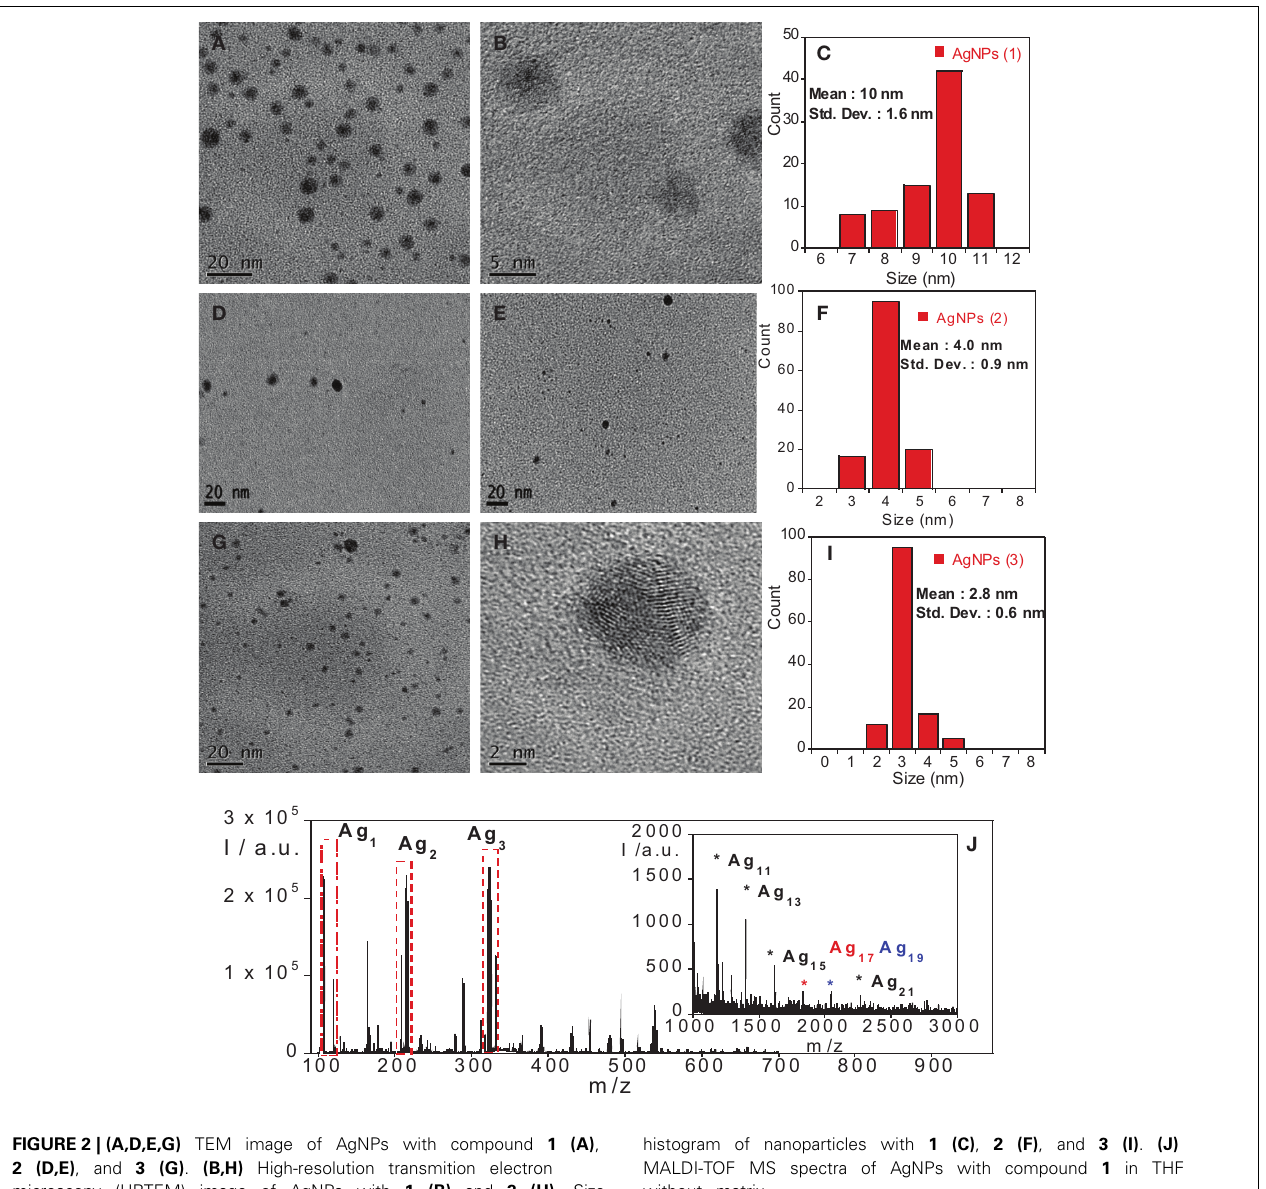
FIGURE 2 | (A,D,E,G) TEM image of AgNPs with compound 1 (A) , 2 (D,E) , and 3 (G) . (B,H) High-resolution transmition electron microscopy (HRTEM) image of AgNPs with 1 (B) and 3 (H) . Size